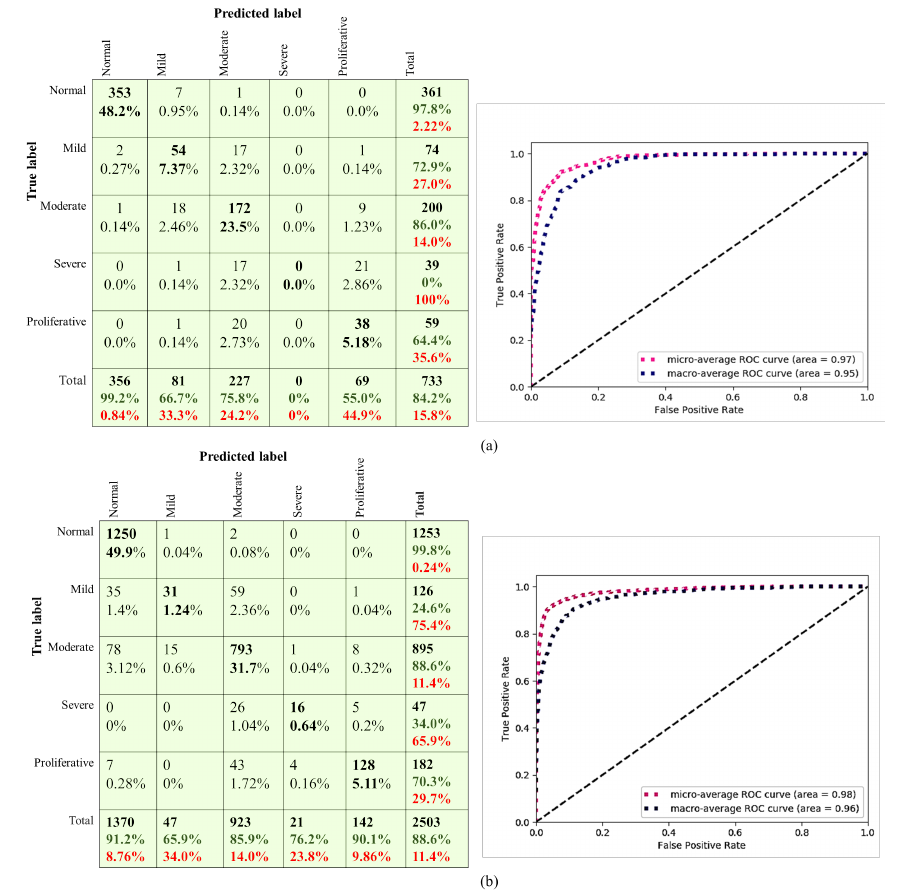
Figure 12. The ROC curves of the ( a ) APTOS 2019 and ( b ) the DDR datasets on CNN512. Table 10. Comparison between the proposed models and the state-of-the-art models on the DDR dataset. Model